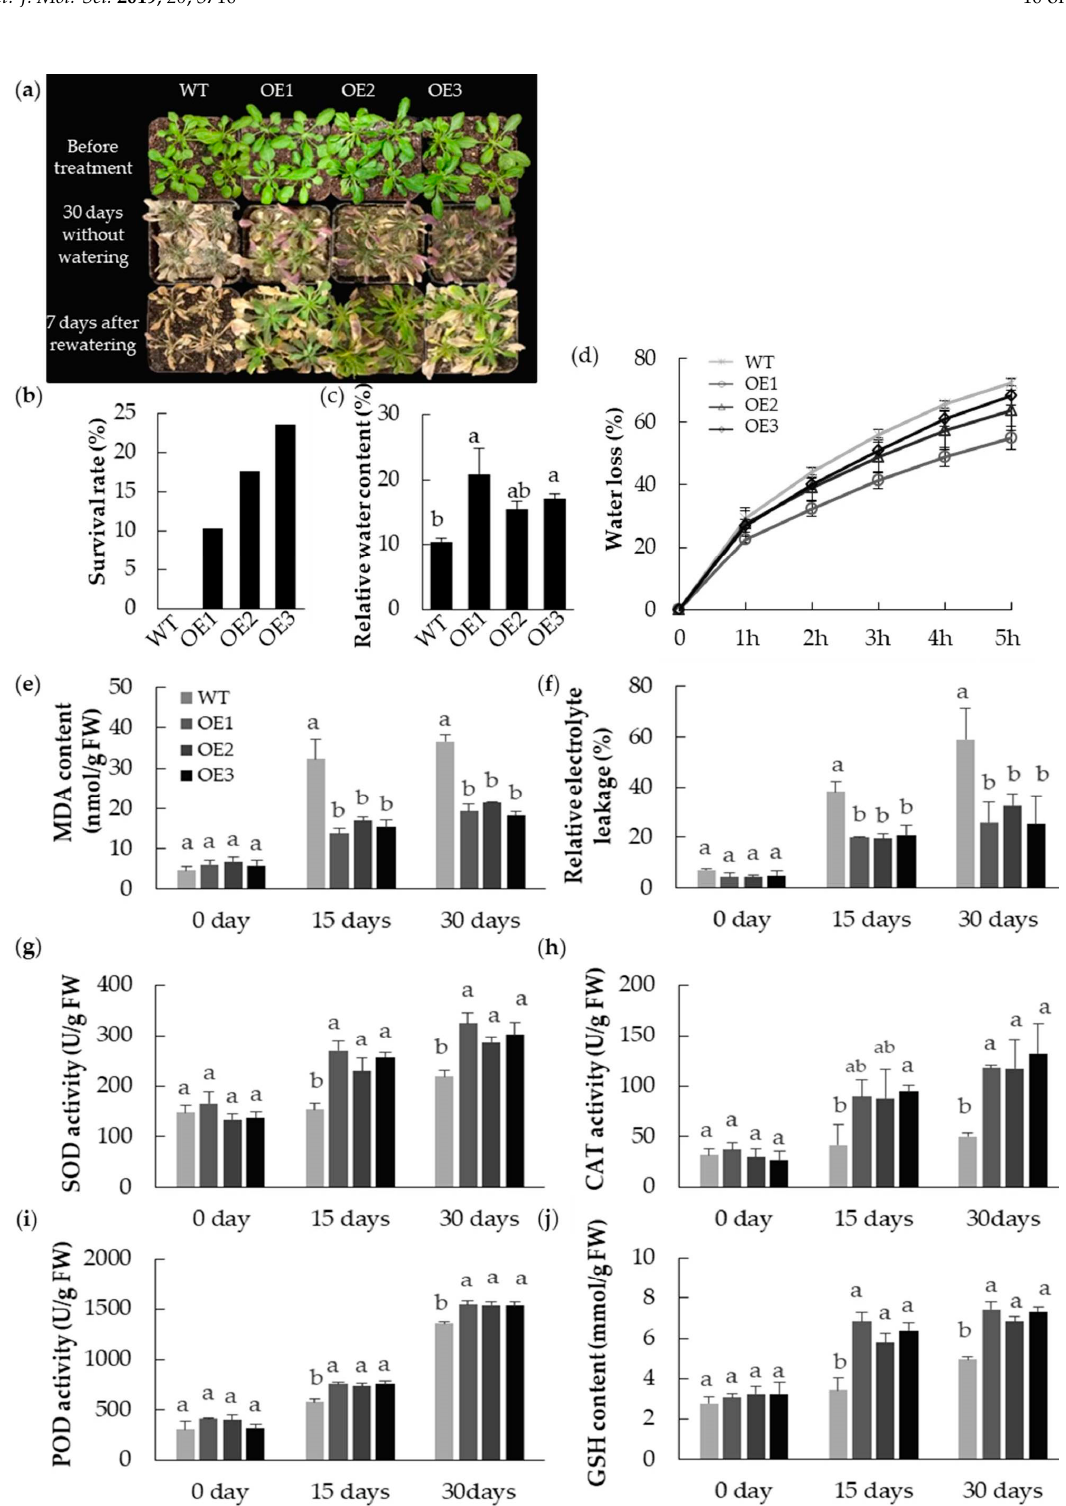
Figure 7. Heterologous expressing MpPIP2;1 enhanced drought tolerance in A. thaliana . ( a ) Phenotypes of transgenic lines and wild type plants under drought stress; ( b ) survival rate after 30 days withholding of water and 7 days after rewatering; ( c ) relative water content after 30 days withholding of water; ( d ) water loss rate of detached leaves; ( e ) malondialdehyde (MDA) content; ( f ) relative electrolyte leakage; ( g ) superoxide dismutase (SOD) activity; ( h ) catalase (CAT) activity; ( i ) peroxidase (POD) activity; and ( j ) glutathione (GSH) content at 0, 15, and 30 days after water withheld. The value presented was the mean ± SD of three replicates, and the bar with di ff erent letter was significantly di ff erent between plants at p < 0.05.